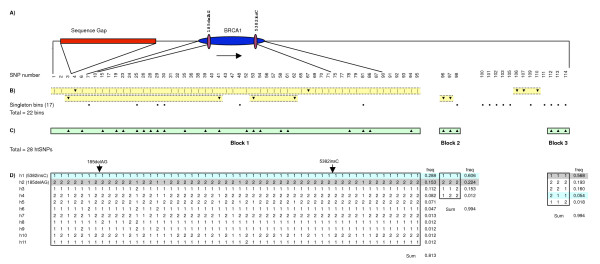
Pair-wise measures of linkage disequilibrium and the two founder mutation-containing haplotypes. SNP number refers to numbering in column 1 of Table 1; only the 70 with MAF ≥ 0.05 in Ashkenazi Jews are shown in B-D. A) Scale representation of the ~650 kb region studied, indicating the BRCA1 gene, founder mutations, and genome sequence gap of unknown true size. B) LDSelect-Comp output showing a total of 22 bins for Ashkenazi Jews, with 17 "singleton" bins indicated by solid dots on a single row. C) Haploview output showing three block structures and related ht-SNPs (indicated with up arrowheads). D) Haplotypes estimated for 85 unrelated Ashkenazi Jews using SNPHAP as implemented in HapScope. The block boundaries were calculated in Haploview and overlaid on this figure. All haplotypes with an estimated frequency of at least 1% are displayed (h1 to h11), with individual frequencies and sums indicated to the right of the blocks. The common allele is designated "1" and the minor allele "2". The 185delAG and 5382insC containing haplotypes, determined from the family based genotypes, are indicated with gray (haplotype 2) and blue background (haplotype 1), respectively. Black arrows indicate the relative position of these two founder mutations.